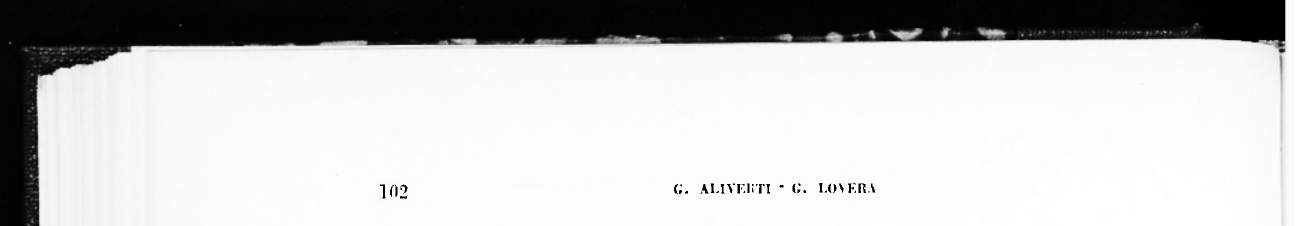
figura 7 ed è c o me si